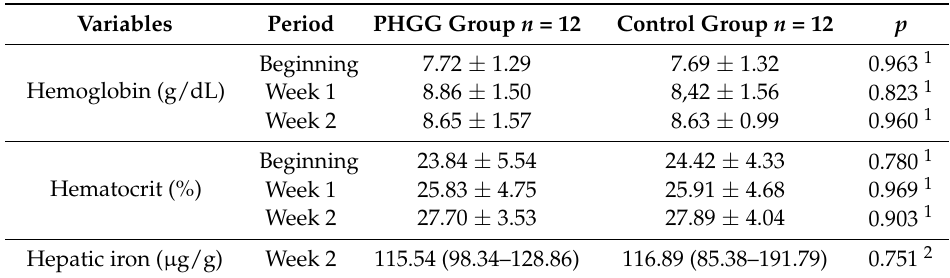
Table 3. Values for hemoglobin, hematocrit, and hepatic iron levels of the animals of the partially hydrolyzed guar gum (PHGG) and control groups in the different study periods.